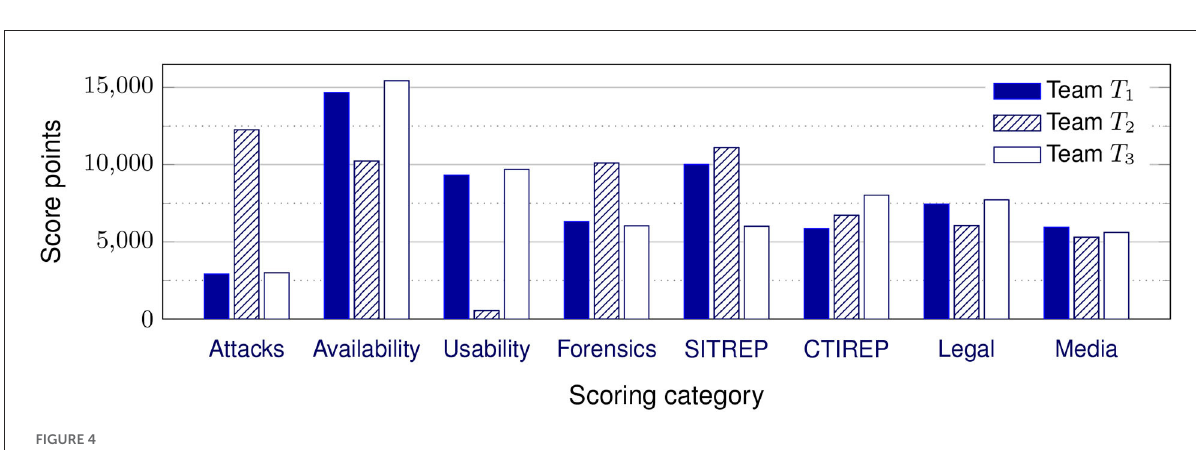
FIGURE4 Comparing three teams with very similar total